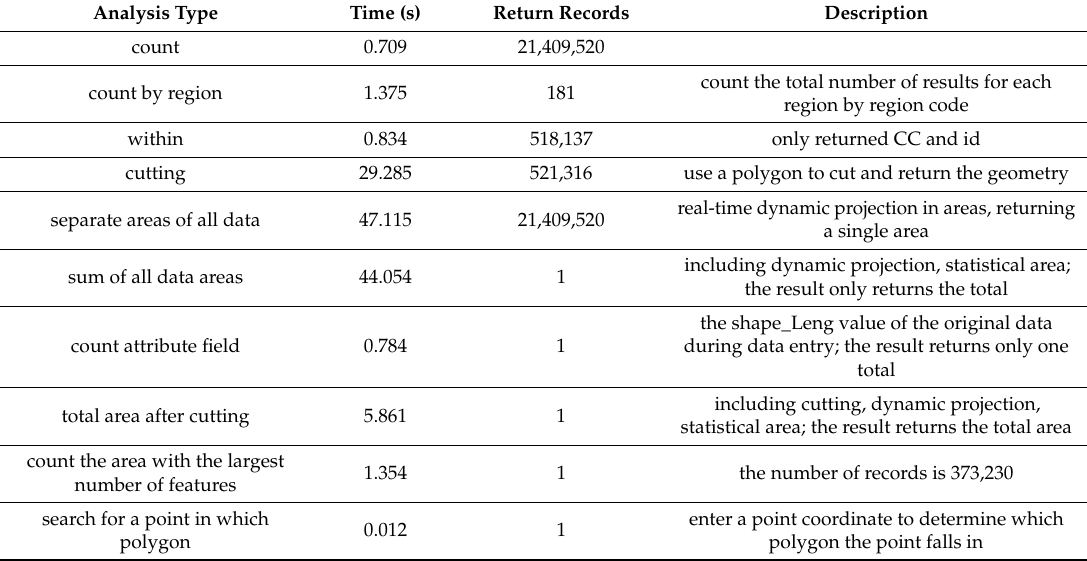
Figure 11. Comparison of different software spatial analysis efficiencies. The amount of data is 2.3 million, with 2,292,765 rows of water systems data for a 3100 km long and 20 km wide buffer area. ( a ) Buffer analysis (s). The stand-alone (single-threaded) CPU usage of ArcGIS is approximately 35%, the single-machine (eight parallel tasks) CPU usage is 100%. ( b ) Buffer clipping (s). ArcGIS uses the toolbox clip tool, and a single machine does not optimize within 636.7 s, single machine with eight parallel tasks does not optimize within 637.5 s (in this way, despite the eight parallel settings, single-threaded tasks are actually still conducted), and stand-alone ArcGIS (single thread CPU usage is approximately 35%, and the single-machine (with eight parallel tasks) CPU usage is 100%. ( c ) Statistical area with real-time calculation. The stand-alone machine (eight parallel tasks) is in fact single-threaded, with no parallelism. The precalculated area is calculated by first calculating the area as an attribute for each feature. The statistical area accumulates the area properties of each feature. Table 6. Use clustering for SQL spatial